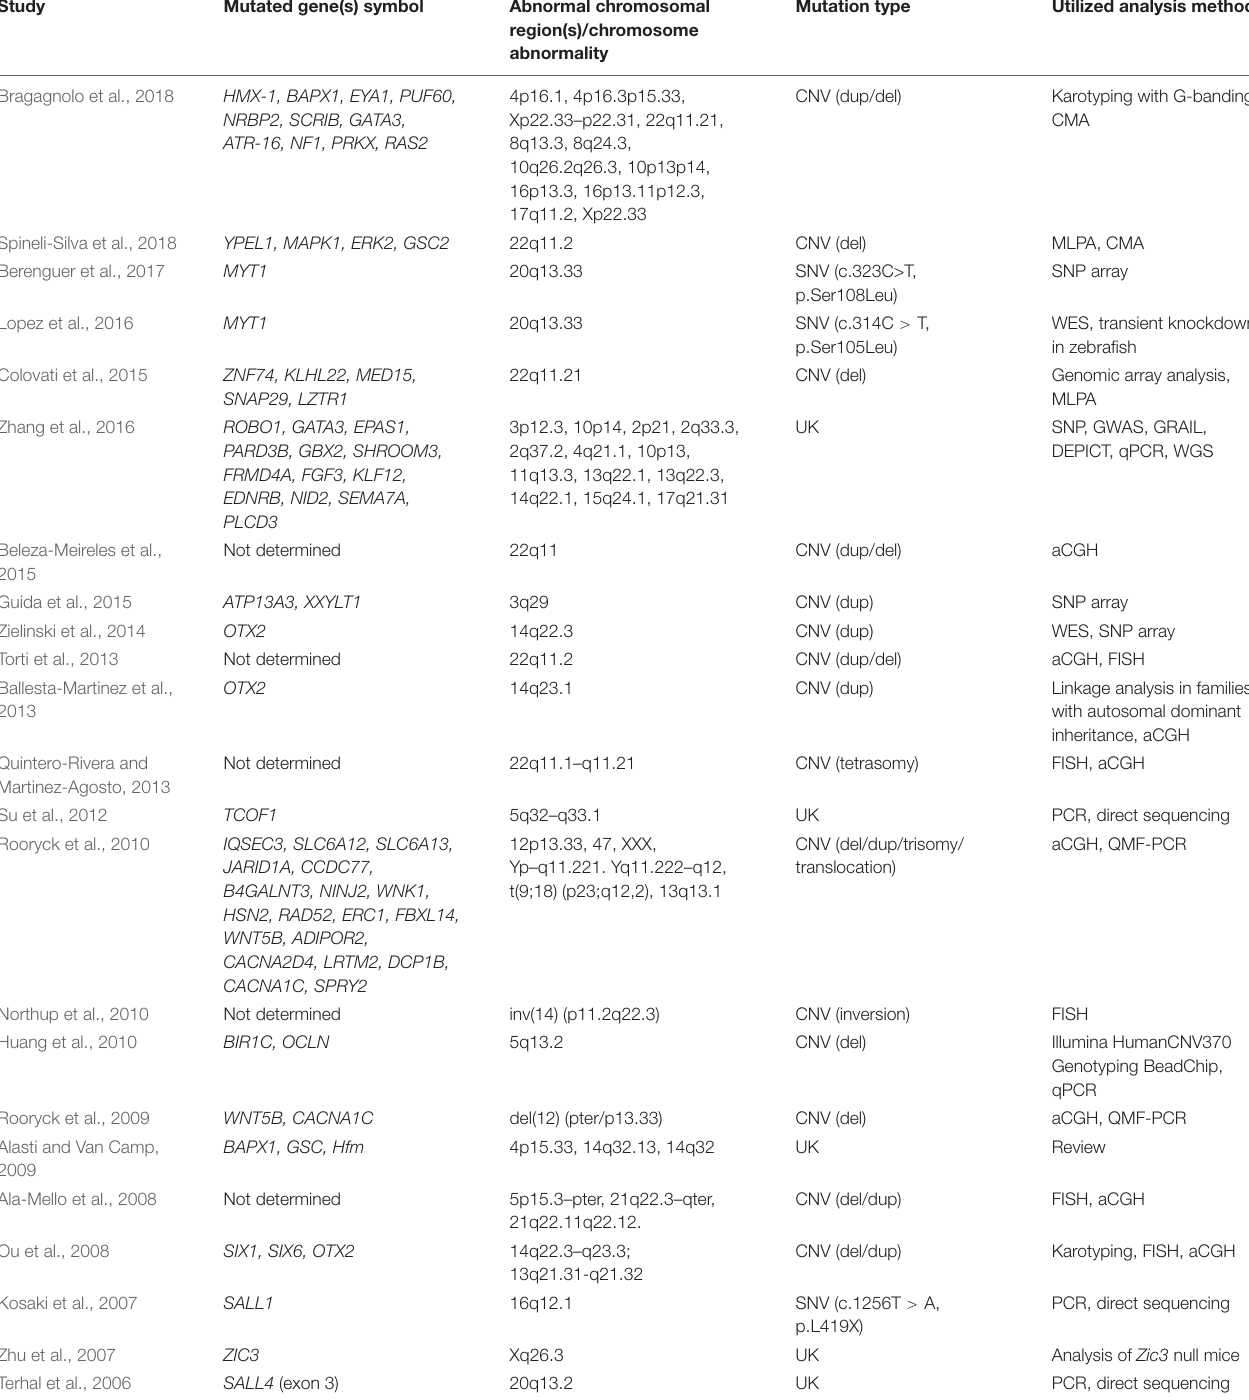
TABLE 2 | Summary of previous genetic studies of hemifacial